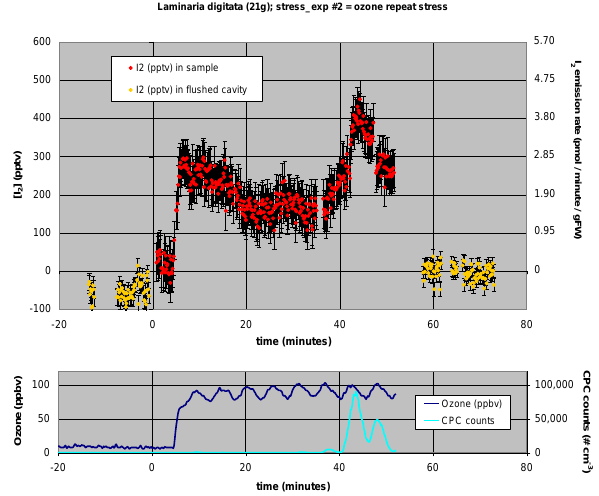
Fig. 6. Time series of I 2 mixing ratios and emission rates for the L. digitata ozone re-stressing experiment #2 (upper panel). The lower panel shows time series of the ozone concentration (dark blue) and the particle number concentration (light blue).